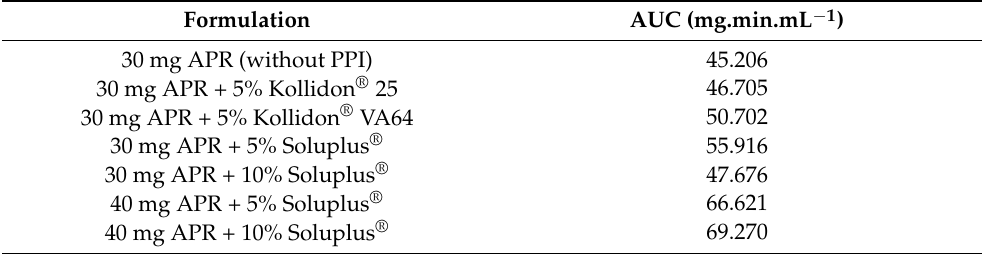
Table 7. AUC of super-SNEDDS formulations after dilution with distilled water.